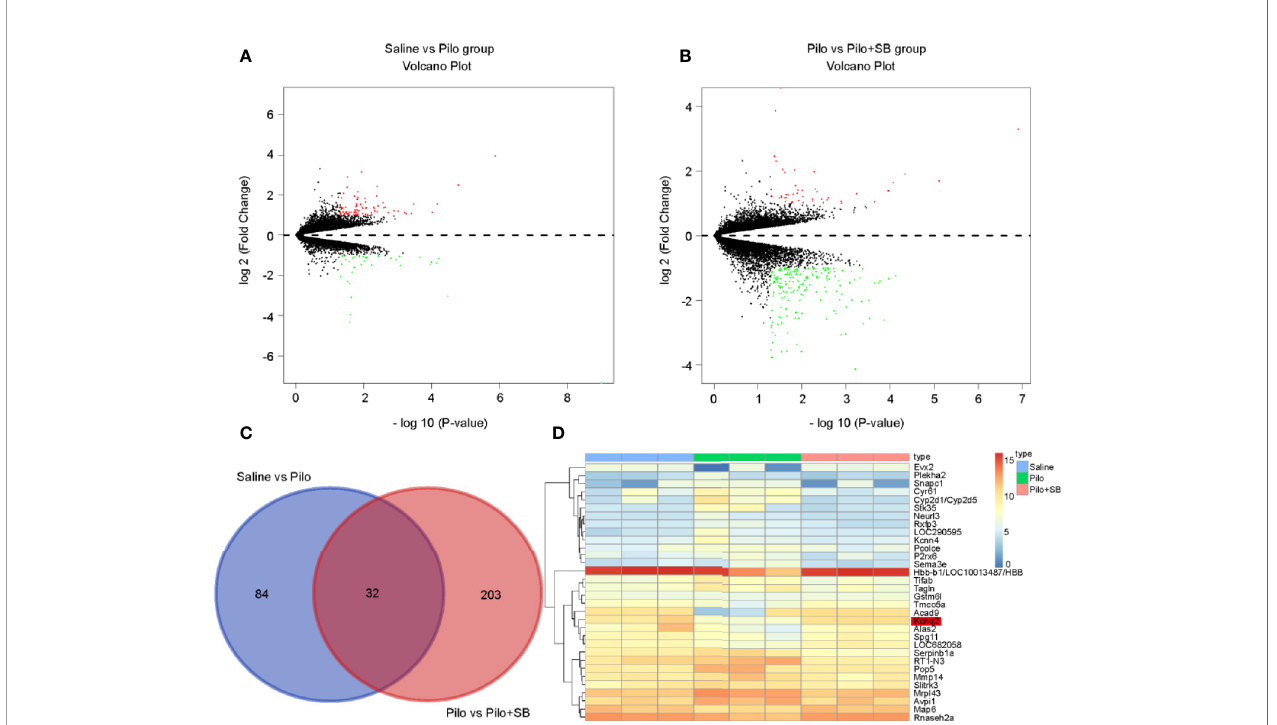
FIGURE 1 | Thirty-two signi fi cant differentially expressed genes (DEGs) were identi fi ed in epilepsy after SB271046 treatment. (A) Volcano plot showing the DEGs identi fi ed between the Saline and Pilo groups. (B) Volcano plot showing the DEGs identi fi ed between the Pilo and SB271046 treatment groups (each group n=3). The x-axis represents log-transformed P-value, and the y-axis indicates the mean expression differences of genes. Note: The two volcano plots show all of the DEGs; the black dots represent genes that are not differentially expressed, and the green dots and red dots represent the downregulated and upregulated genes, respectively. |log2FC| > 1 and p-value < 0.05 were set as the cut-off criteria. (C) The intersection of DEGs of the Saline vs Pilo group and Pilo vs SB271046 treatment group. (D) Heatmap of differential expressed genes between the Saline, Pilo and SB271046 treatment